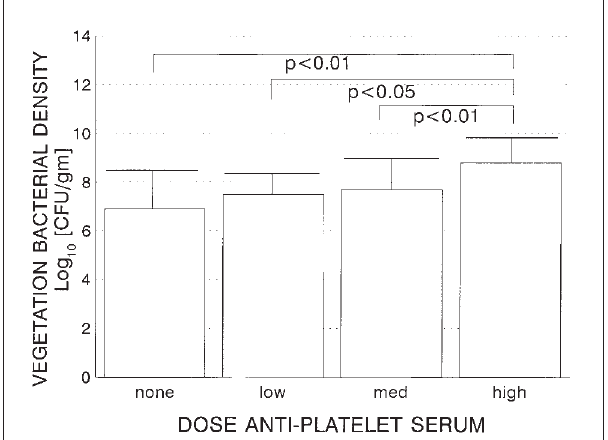
Figure 1) Bacterial endocarditis vegetations with antiplatelet serum administration. Bacterial density (log 10 [colony forming units{cfu}/gram vegetation weight]), with standard deviation, is pre- sented at different doses of antiplatelet serum in the rat model of endo- carditis. Significance shown between groups was calculated by ANOVA and Student-Newman-Keuls multiple comparisons post-test. No dose Received no antiplatelet serum but was injected with a volume of normal rabbit serum equal to the dose received by antiplatelet ani- mals run concurrently (6.9 (cid:2) 1.1, n=16); Low dose Received